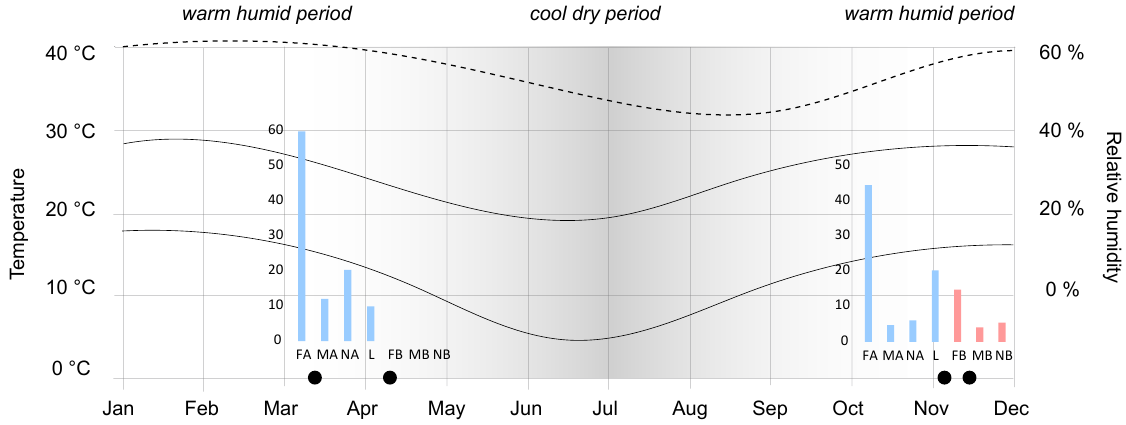
Figure 8. Climatic characteristics of the type locality of Aberoptus schotiae n. sp. and abundance (%) of the morphotypes A (blue) and B (pink) in the samples collected in 2013–2017 in South Africa. Average relative humidity (dotted line), minimum (lower solid line), and maximum (upper solid line) temperature in Pretoria depicted, based on data from https://weather-and-climate.com (accessed on 22 September 2022). Notations: L—larvi; FA, MA, NA, FB, MB, NB—females (F), males (M), and nymphs (N) of morphotypes A and B. The area marked by gray gradient indicates the cool-dry period of the year in